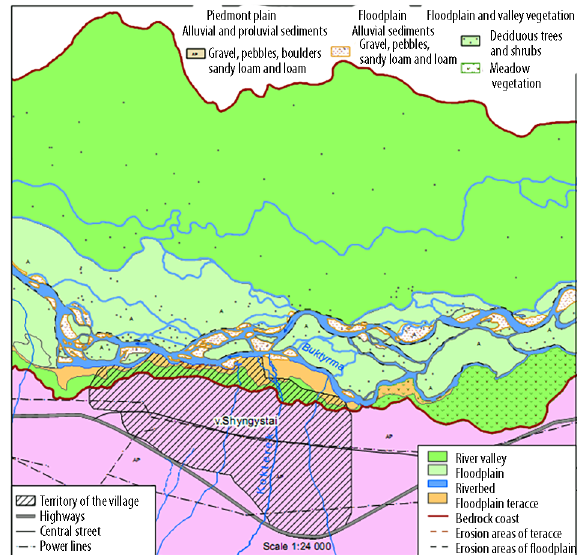
Figure 4. Scheme of eroded areas of the Buktyrma River near Shyngystai